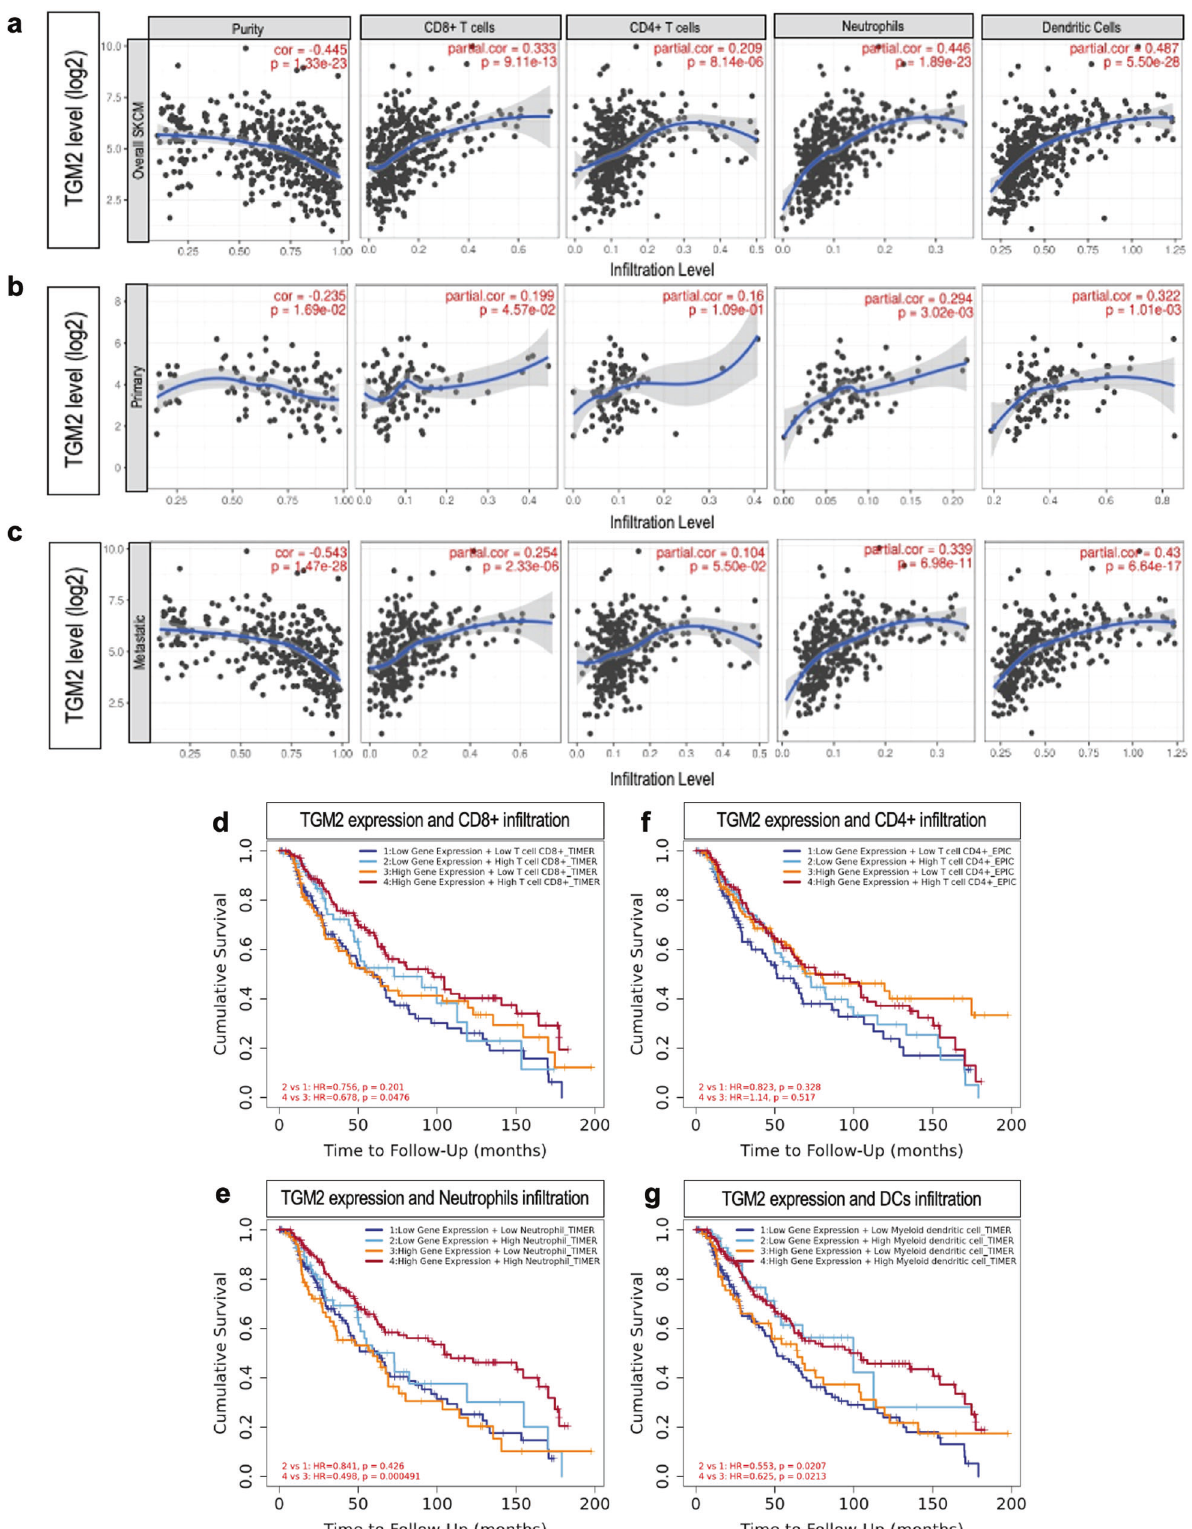
Fig. 6 TGM2 correlation with in fi ltrating immune cells and prognostic value in SKCM. a – c Correlation between TGM2 level of expression and immune in fi ltration cell types was obtained in overall, primary and metastatic SKCM. d − g Overall survival analysis was retrieved through Kaplan – Meier by sorting samples for high and low TGM2 level of expression and immune cell types in fi ltration in SKCM, according to their median. These analyses were performed using TIMER (* p < 0.05; ** p < 0.01; *** p < 0.001). Fifteen panels, showing the purity-corrected partial Spearman correlation and statistical signi fi cance between TGM2 expression and each SKCM subset, were displayed.